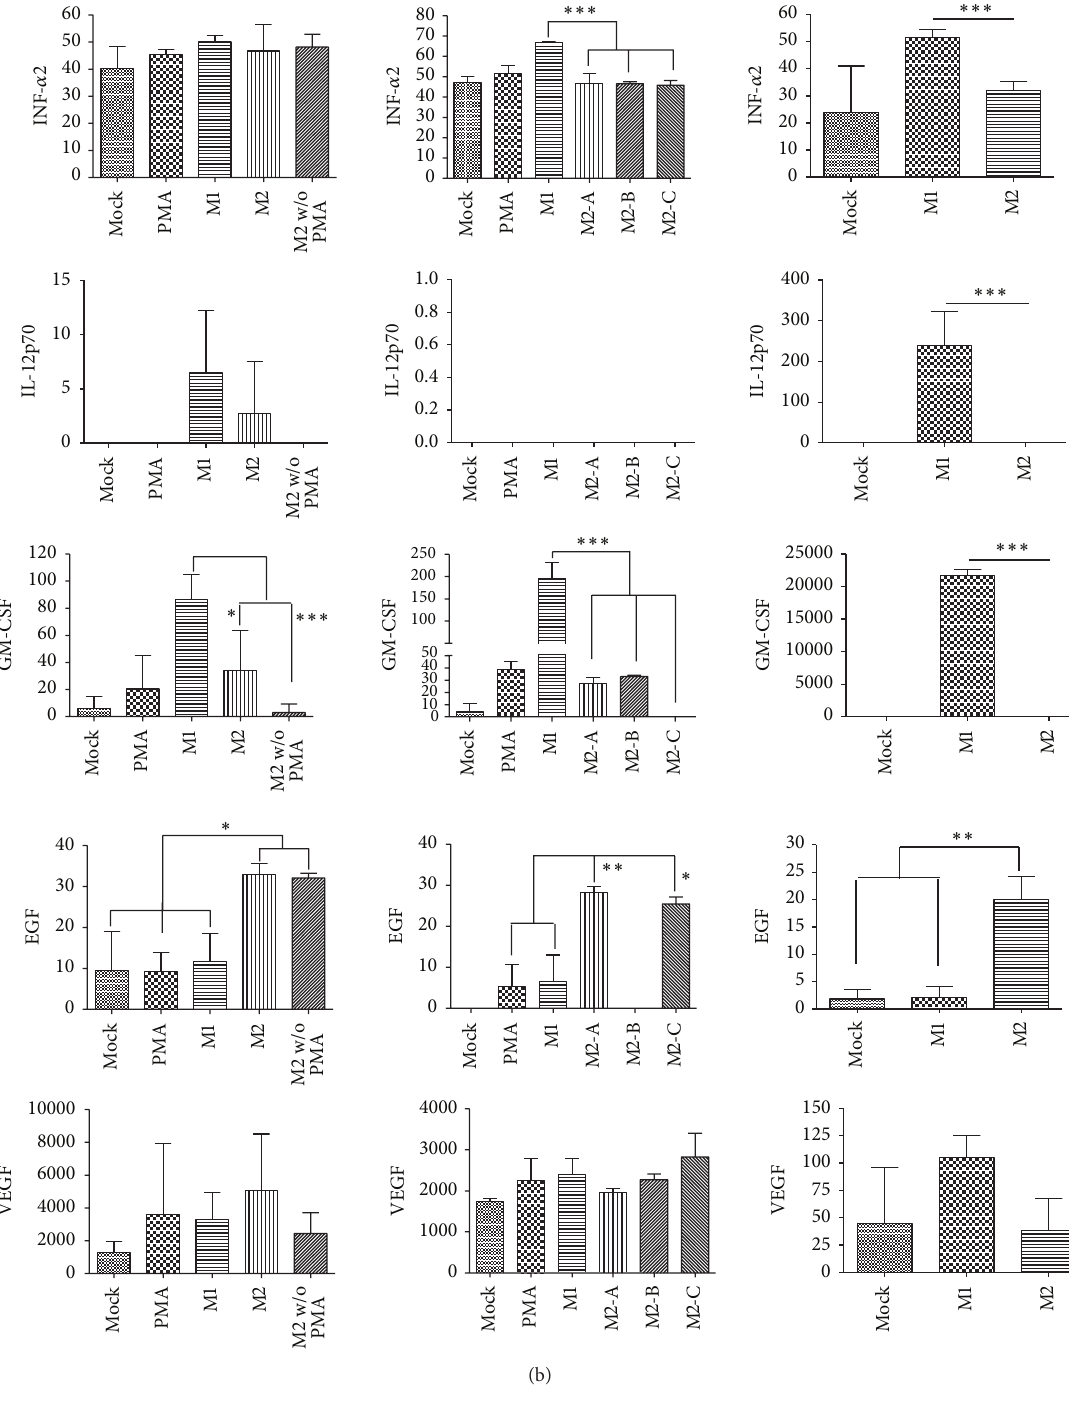
Figure 5: Analysis of the profile of cytokine expression. Concentrations expressed in pg/mL of IL-1 𝛽 , IL-8, RANTES, G-CSF, MCP-1, INF- 𝛼 2, IL-12p70, GM-CSF, EGF, and VEGF measured in supernatants harvested from all different polarizing treatments and controls and analyzed in the Luminex MAGPIX (cid:2) multiplexing instrument. For THP-1, mock: no stimulated cells; PMA: PMA-only control; M1: PMA + LPS + INF- 𝛾 ; M2: PMA + IL-4 + IL-13; and M2 w/o PMA: IL-4 + IL-13. For U937, mock: no stimulated cells; PMA: PMA-only control; M1: PMA + LPS + INF- 𝛾 ; M2-A: PMA + IL-4 + IL-13; M2-B: PMA + M-CSF; and M2-C: IL-4 + IL-13. For primary monocytes, mock: no stimulated cells; M1: GM-CSF + LPS + INF- 𝛾 ; and M2: M-CSF + IL-4 + IL-13. U937 cells did not produce IL-12p70 under any condition. Asterisks and bars denote statistical significance between conditions. Significance ≤ 0.05 was indicated with ∗ , ≤ 0.01 was indicated with ∗∗ , and ≤ 0.0005 was indicated with ∗∗∗ . In THP-1 cells IL-1 𝛽 , IL-8, G-CSF, and GM-CSF were significantly different between M1 versus M2 and M2 without PMA; EGF, (mock, PMA, and M1) versus M2 and M2 without PMA. In U937 cells IL-1 𝛽 , G-CSF, INF- 𝛼 2, and GM-CSF, M1 versus (M2-A, M2-B, and M2-C); EGF, PMA and M1 versus M2-A and M2-C. In primary monocytes IL-1 𝛽 , IL-8, RANTES, G-CSF, INF- 𝛼 2, IL-12p70, and GM-CSF, M1 versus M2; EGF, mock and M1 versus